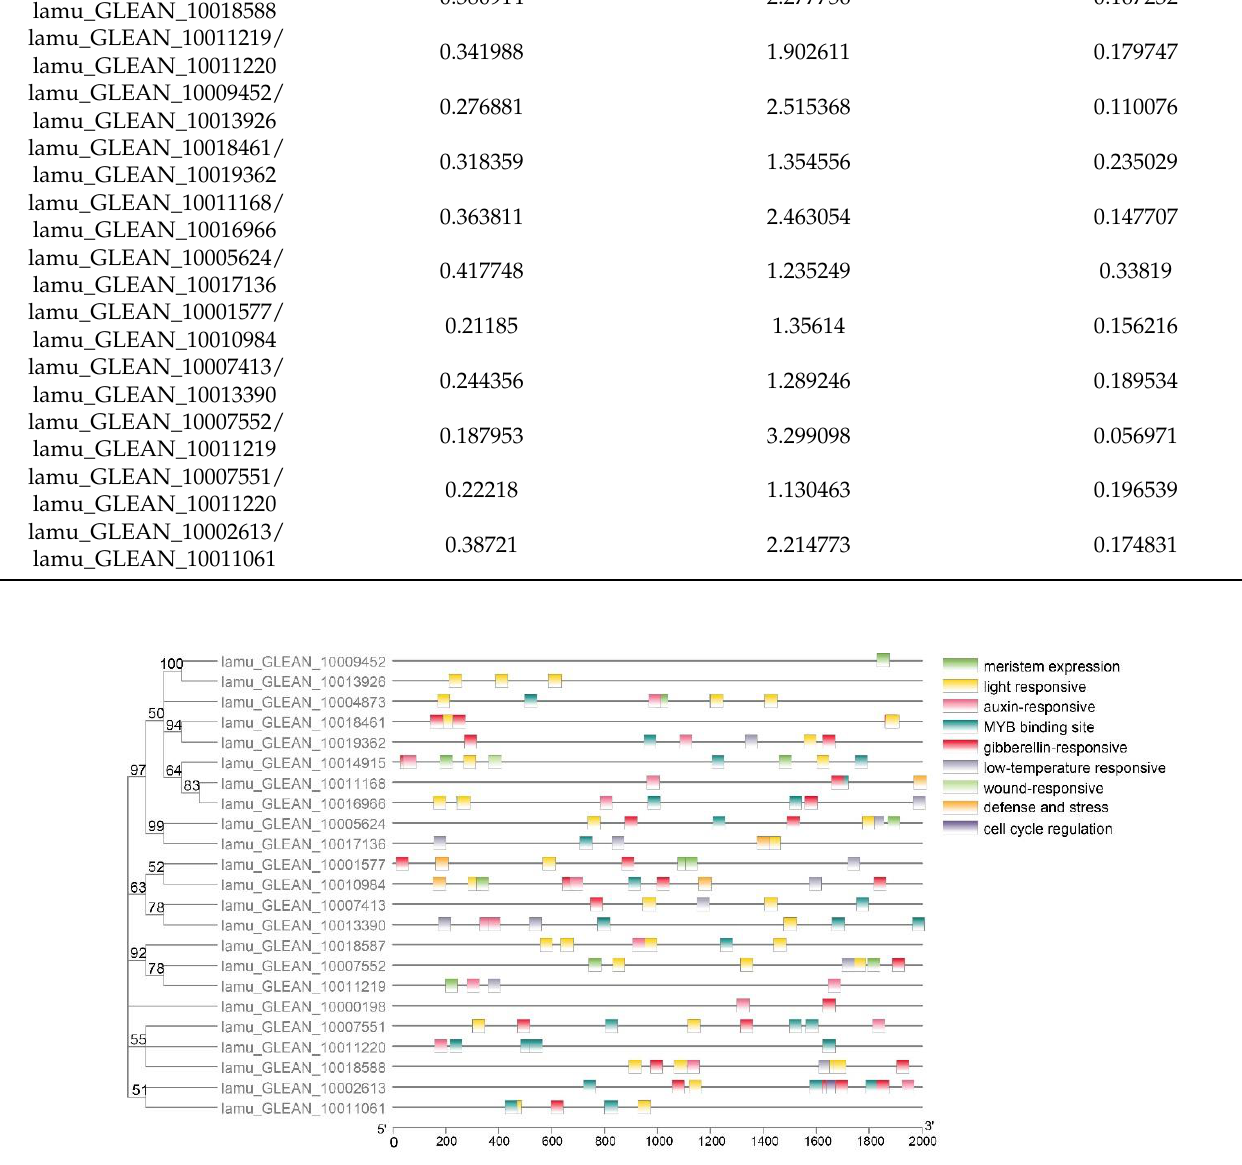
Figure 4. Prediction and visualization of cis-elements in MoIAA promoters.